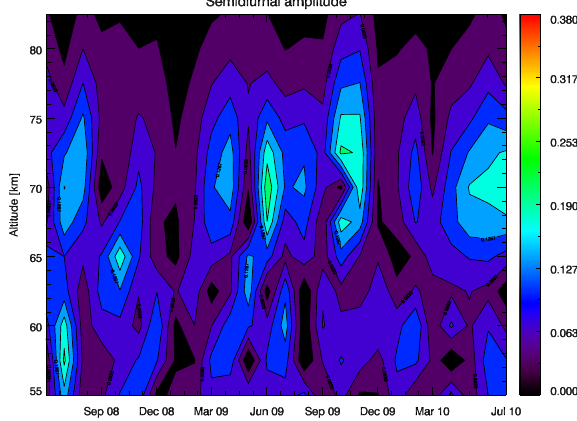
Fig. 4. As Fig. 3, but for the semidiurnal